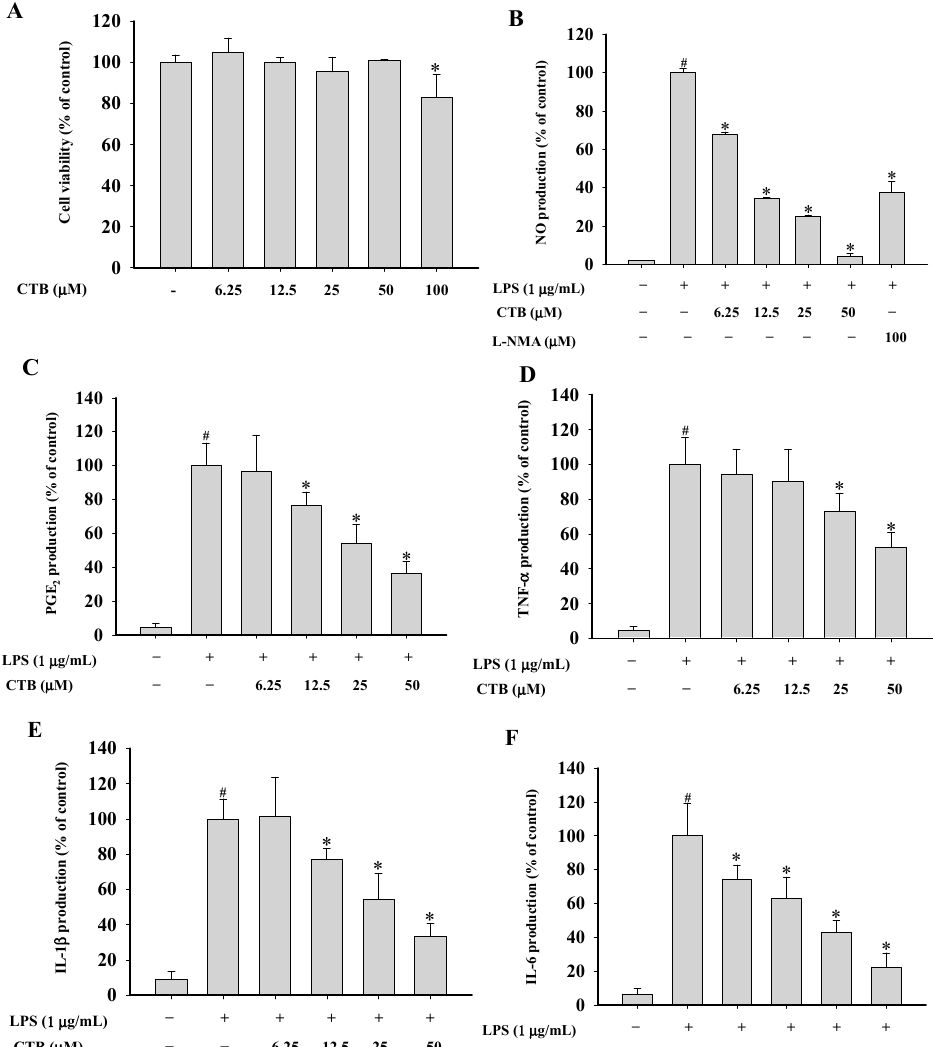
Figure 2. Effects of CTB on cell viability ( A ) and nitric oxide (NO) ( B ); prostaglandin E 2 (PGE 2 ) ( C ); tumor necrosis factor α (TNF- α ) ( D ); interleukin-1 β (IL-1 β ) ( E ); and IL-6 ( F ) production in RAW264.7 cells. ( A ) RAW264.7 cells were seeded in 96-well plates and treated with CTB at the indicated concentrations for 24 h. Cell proliferation was estimated by the 1-(4,5-dimethylthiazol-2-yl)-3,5-diphenylformazan (MTT) assay ( A ); RAW264.7 cells were seeded in 96-well plates and pre-treated with CTB for 30 min before the addition of 1 µg/mL LPS for 24 h. Supernatants were collected, and NO levels in culture media were determined using Griess assays ( B ); Levels of PGE 2 , TNF- α , IL-1 β , and IL-6 in culture media were quantified using enzyme-linked immunosorbent assay (ELISA) kits ( C – F ). Values are the mean ± standard derivation (SD) of triplicate experiments. * p < 0.05 compared to LPS treatment alone; # p < 0.05 compared to control group.